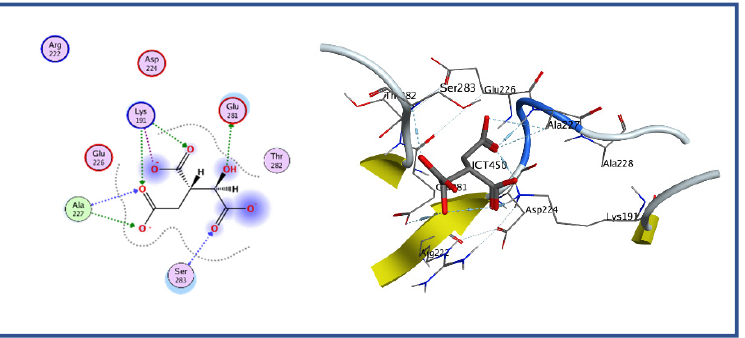
Figure 6. Docking analysis for ICT. Docking study for ICT against ICL active site showing binding affinity of − 6.9 kcal/mol.